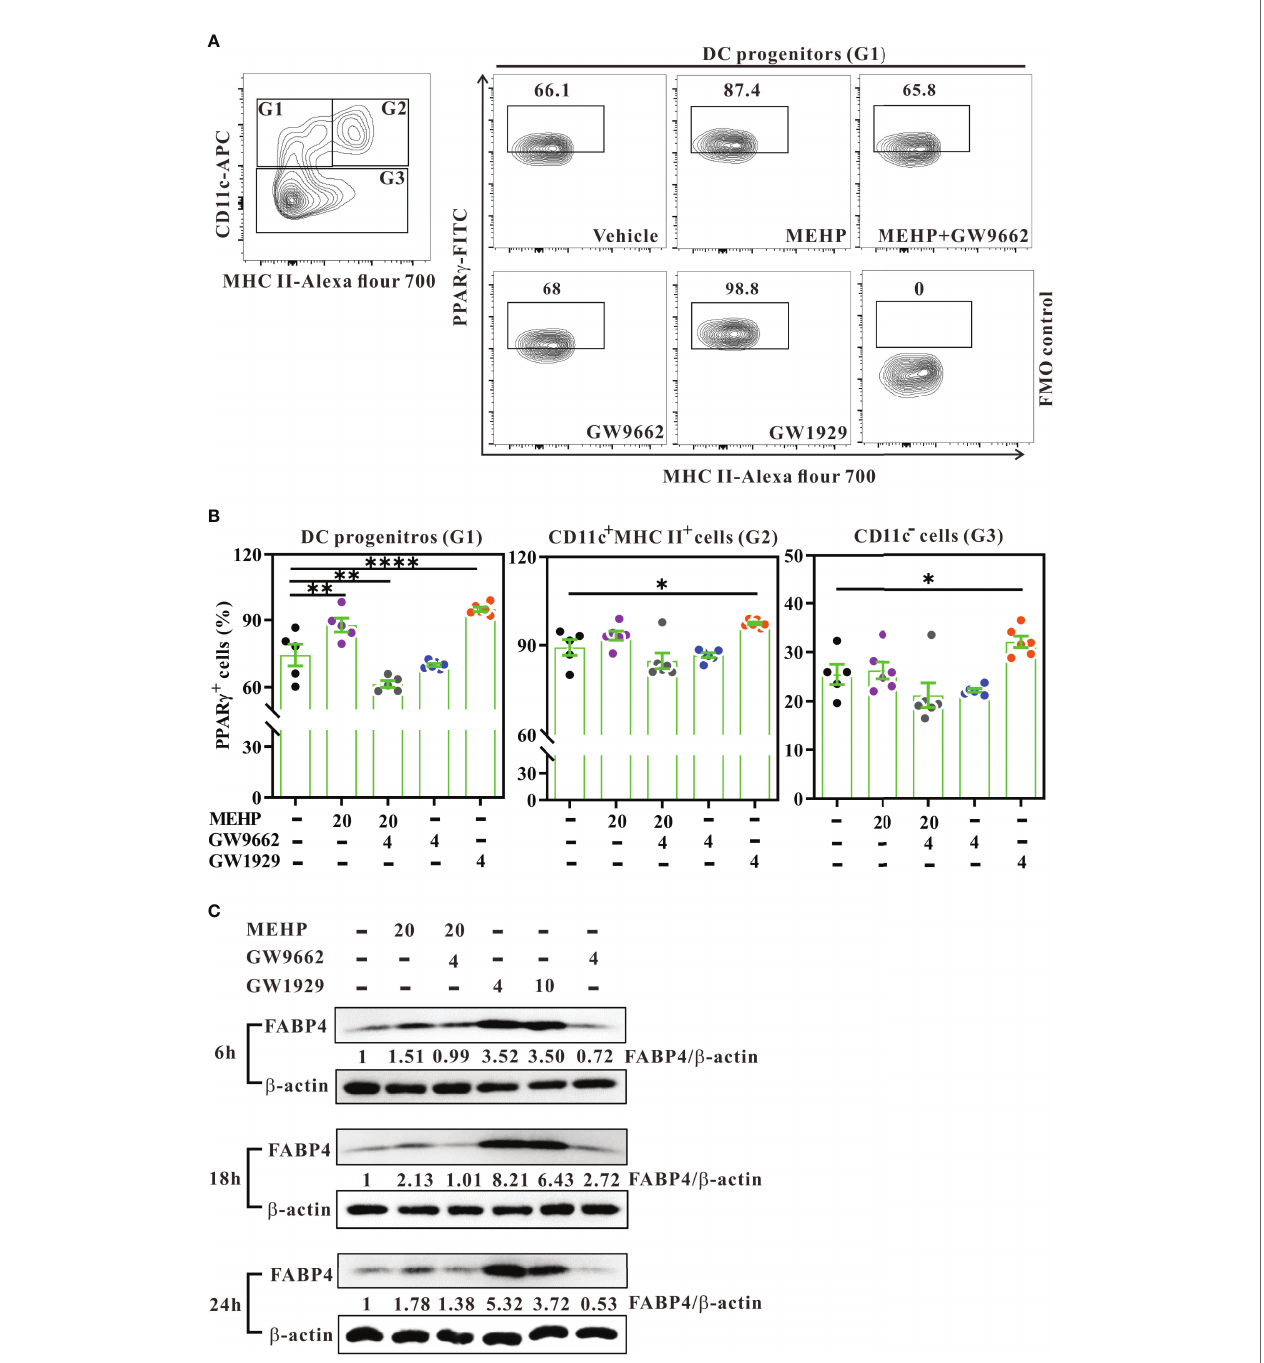
FIGURE 6 | Expression and activity of PPAR g in Flt3L-induced bone-marrow culture. (A) Day-3 Flt3L-differentiated bone marrow cells were treated with various concentrations ( m M) of MEHP, GW1929, and/or GW9662 for 6 h and then analyzed for PPAR g expression using multi-parametric fl ow cytometry. Representative contour plots showing intracellular PPAR g expression in DC progenitors (G1, CD11c + MHC class II - ) from treated cells gated on viable Lin - bone marrow cells. PPAR g + cells were gated against fl uorescence minus one (FMO) control. (B) Percentages of PPAR g + cells in each subset. n=5 or 6 mice for each group. Results are represented as mean ± SEM. *P < 0.05, **P < 0.01, and ****P < 0.0001, as assessed using one-way ANOVA followed by Dunnett ’ s multiple comparison test. (C) Estimation of protein levels of FABP4 and b -actin in day-3 Flt3L-differentiated bone marrow cells treated with various conditions for 6, 18, and 24 h, using western blot. Data are representative of two experiments. Results are shown as fold enrichment by normalizing the relative ratio of FABP4 versus b -actin to vehicle